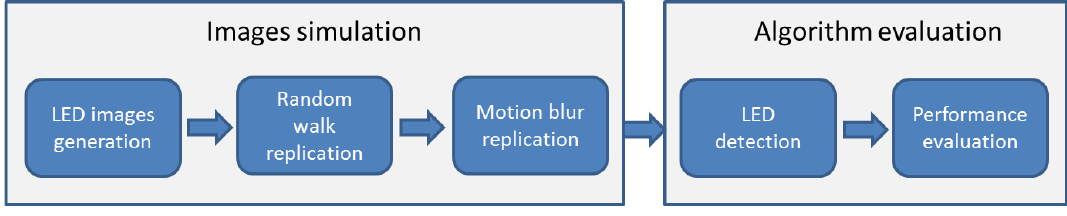
Figure 6. Simulation